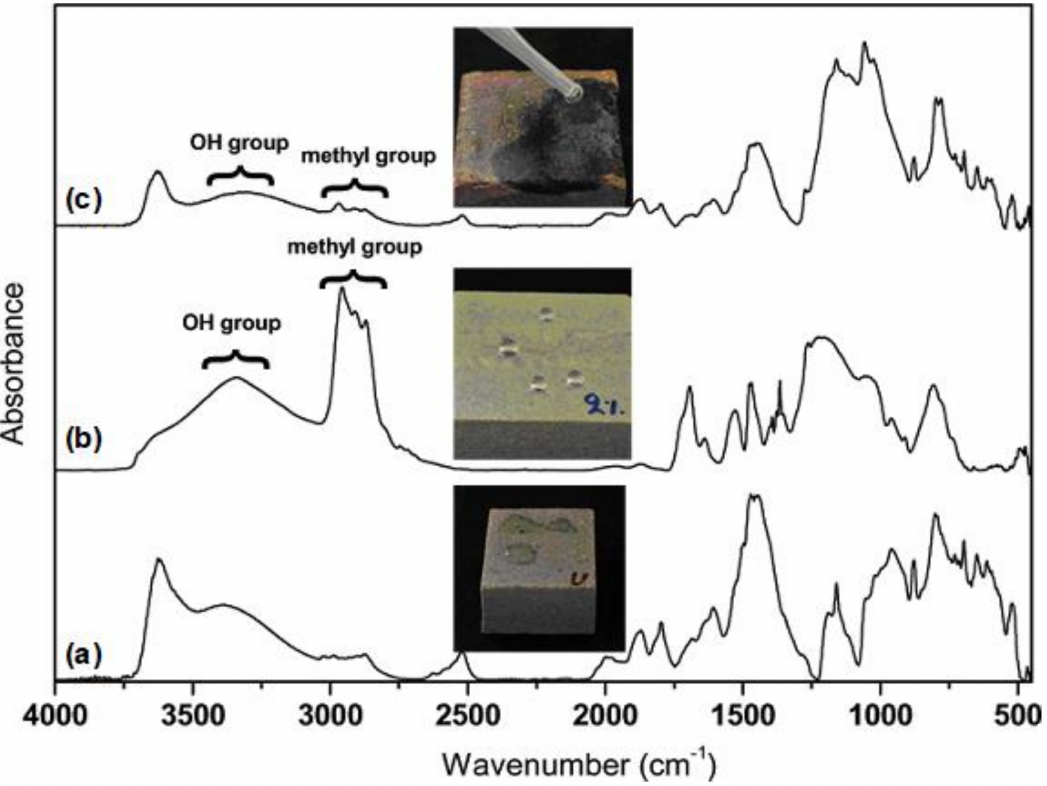
Figure 5. FT-IR spectra of ( a ) bare, uncoated sandstone, ( b ) fresh Silres + nanoparticles coating on sandstone and ( c ) Silres + nanoparticles coating on sandstone after extensive thermal treatment. Photographs which demonstrate the interaction of water drops with the three surfaces are included. In particular, the ( a ) hydrophilic, ( b ) superhydrophobic and ( c ) superhydrophilic properties of the corresponding surfaces are